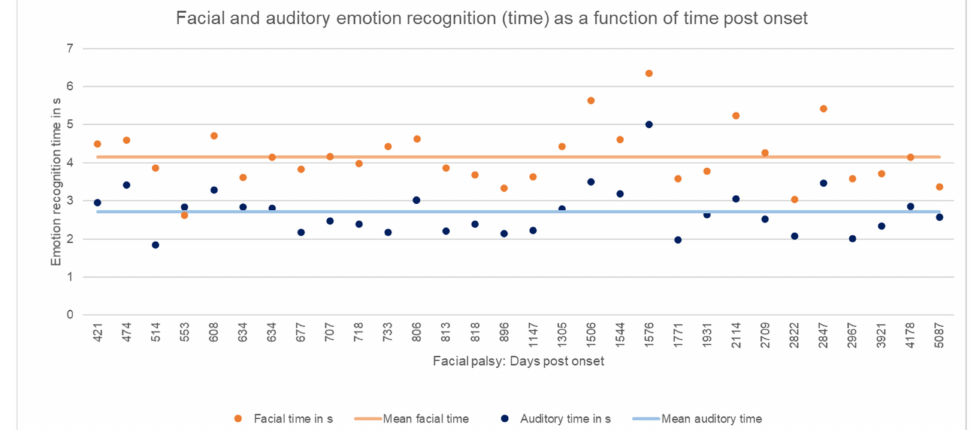
Figure 2. Facial and auditory emotion recognition (time) as a function of time post onset. Individual results of the patients with facial synkinesis are shown as dots in bright orange (facial time) and bright blue (auditory time). Mean of facial accuracy in the patient group is shown as line in pastel orange, and mean of auditory accuracy in the patient group is shown as a line in pastel blue.